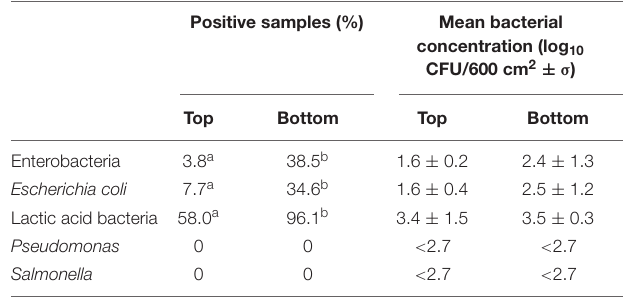
TABLE 2 | Percentage of positive carcasses and mean bacterial concentrations for Enterobacteria Escherichia coli , lactic acid bacteria, Pseudomonas , and Salmonella for the top and bottom areas of the carcass surface samples analyzed.